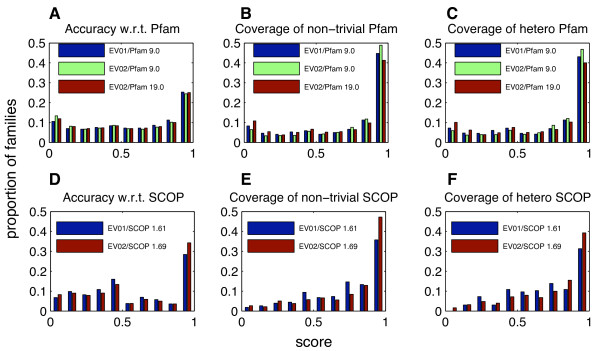
Performance of EVEREST release 1 and EVEREST release 2 with respect to Pfam and SCOP. EV01: EVEREST release 1; EV02: EVEREST release 2. A. Accuracy with respect to Pfam: Histogram of scores of EVEREST families with respect to best matching Pfam families. B. Coverage of non-trivial Pfam families: Histogram over non-trivial Pfam families, of scores of best matching EVEREST families. C. Coverage of hetero Pfam families: Histogram over hetero Pfam families, of scores of best matching EVEREST families. D, E, F: As A, B, C, with SCOP in place of Pfam. See sections Evaluation of Classification, EVEREST Release 2 and Evaluating a Suggested Domain Family for further details.